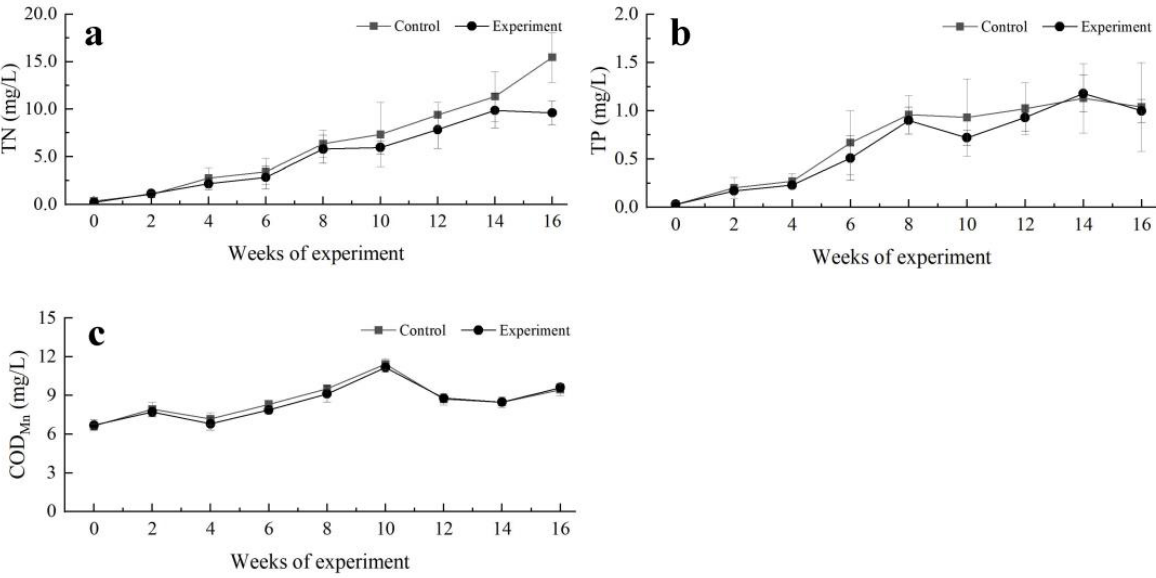
Figure 3. Changes of water quality parameters in the control and treatment group during the experiment. ( a ) TN; ( b ) TP; ( c ) COD. Vertical bars represent the mean ± SD ( n = 3).